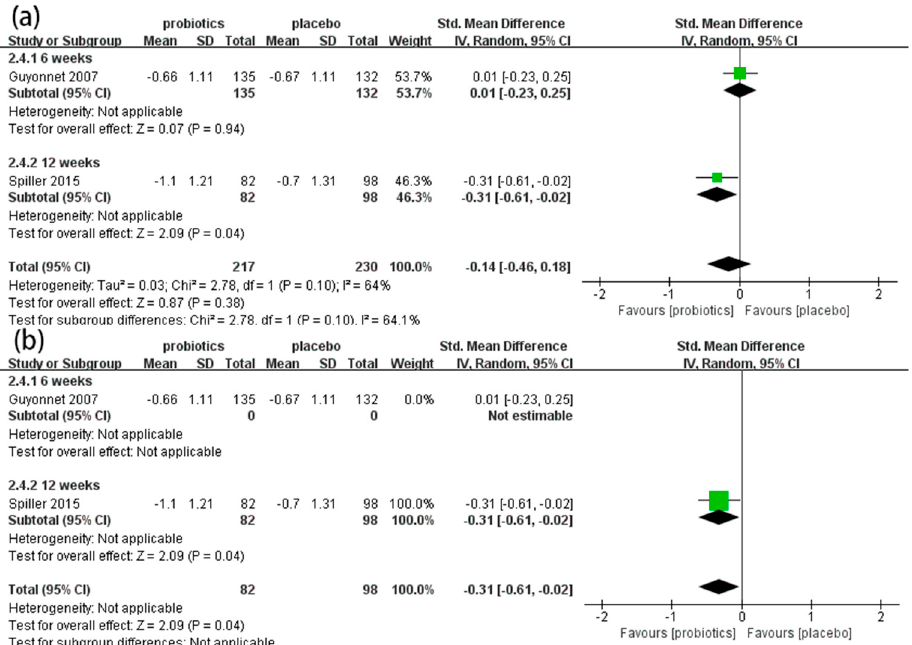
Figure 6. Effect of probiotics on bloating scores in IBS-C patients. ( a ) subgroup analysis for bloating scores; ( b ) sensitivity analysis bloating scores. The green block represents the effect sizes of individual studies, black diamond block represents the combined effect size.